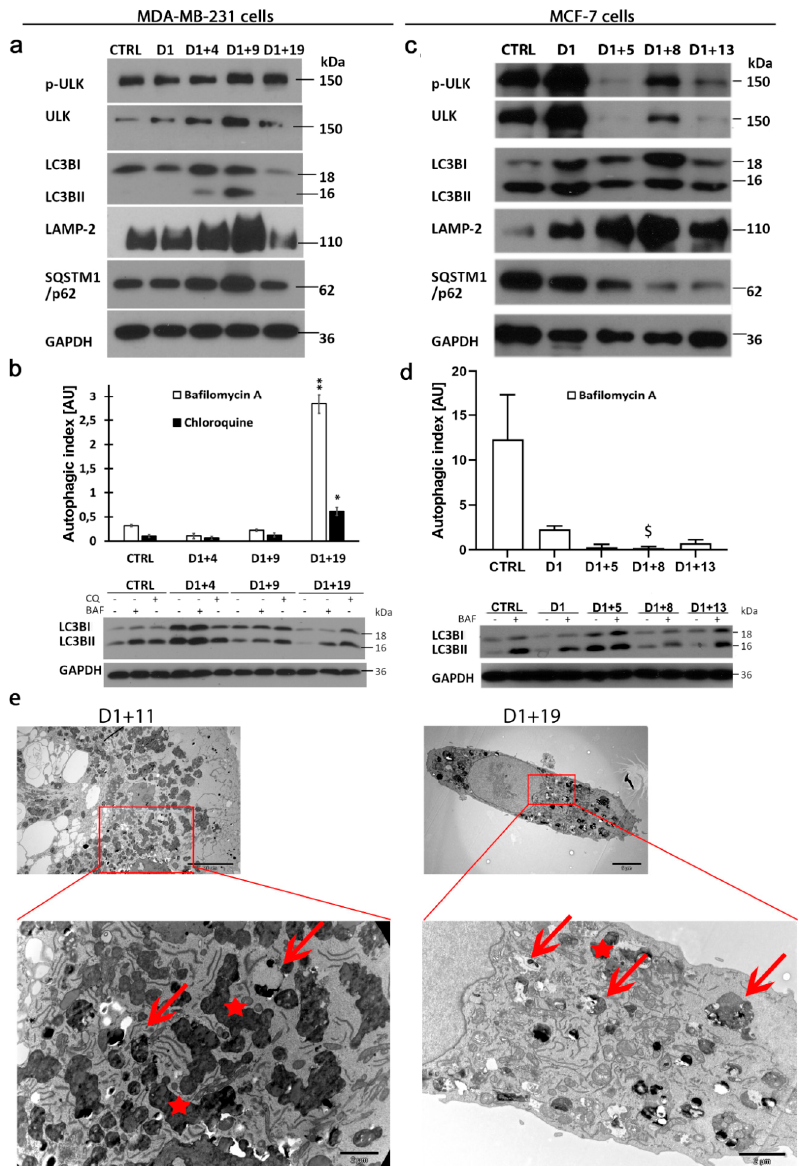
Figure 5. Autophagic flux resumption in descendants of polyploid/senescent MDA-MB-231 and MCF-7 cells. Cells were treated with 100 nM doxorubicin for one day, then cultured in a fresh medium and analyzed on subsequent days. ( a , c ) Representative western blots showing autophagy protein levels of p-ULK1 (S757), ULK1, LC3B, LAMP-2 and SQSTM1/p62 in MDA-MB-231 cells ( a ) and MCF-7 cells ( c ). ( b , d ) Quantitative analysis of autophagic index based on LC3B protein levels in untreated and bafilomycin A- or chloroquine-treated MDA-MB-231 cells ( b ) and MCF-7 cells ( d ) with representative western blots showing LC3B protein levels. Bars: mean value, error bars: SEM, n = 4. Statistical significance (in relation to control): $ p < 0.051, * p < 0.05, ** p < 0.01. ( e ) Transient accumulation of autophagic vesicles. TEM images show typical MDA-MB-231cells on the subsequent days following treatment (upper panel) and their magnified parts with autophagic vesicles (red arrows) and lipofuscin particles (red asterisks).